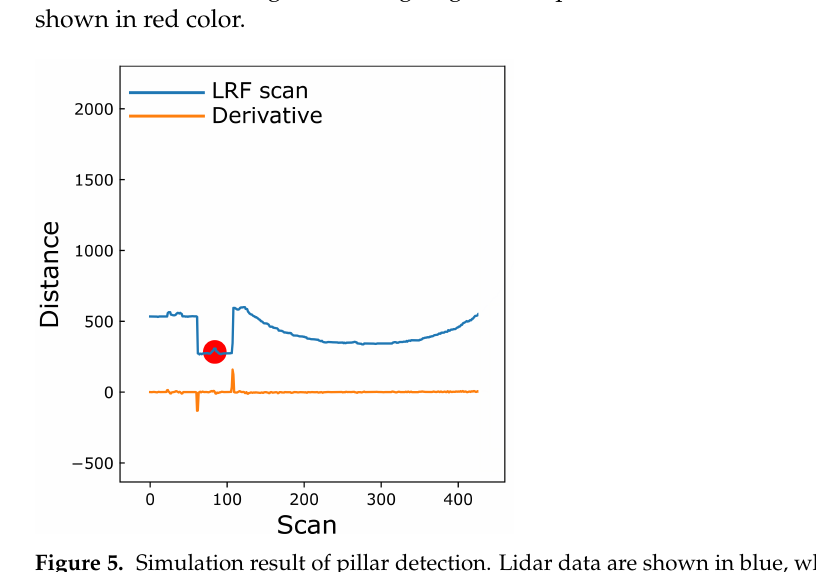
Figure 5. Simulation result of pillar detection. Lidar data are shown in blue, whereas its symmetric derivative is shown in orange color. The detected pillar is shown in red circle between the rising and falling edges of the symmetric